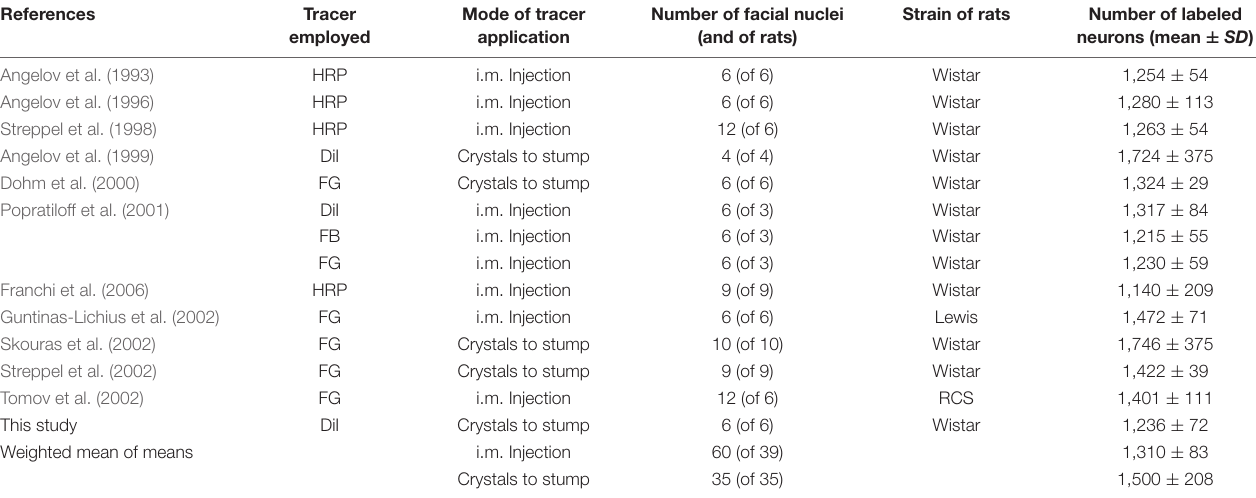
TABLE 1 | Lateral facial subnucleus.